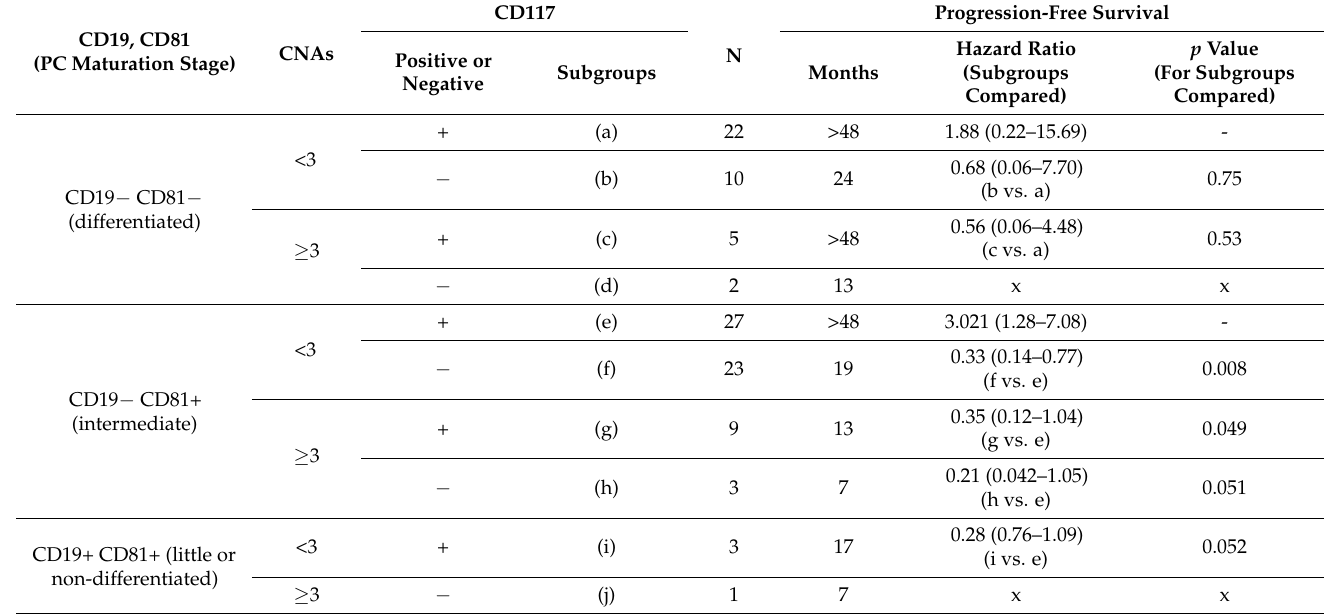
Table 5. Correlation of CD19, CD81 and CD117 expression with adverse CNAs and clinical prognosis of MM patients estimated by Kaplan–Meier and COX regression